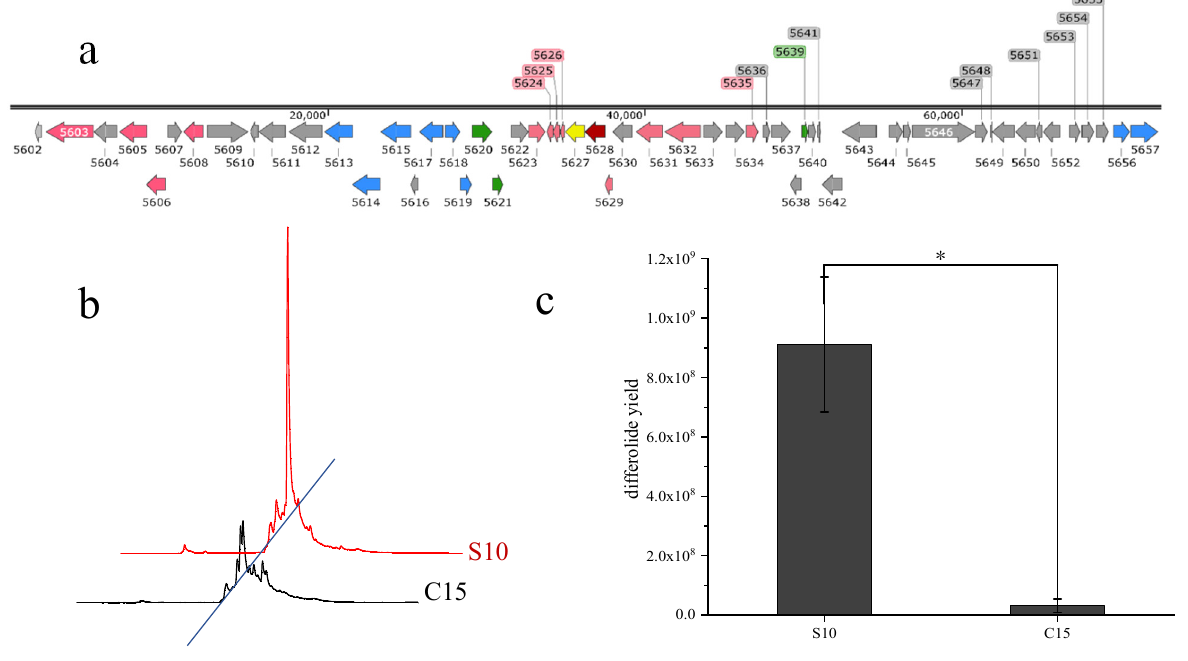
Figure 2. Biosynthesis of (±)-differolide. ( a ): The biosynthesis gene cluster of (±)-differolide (The function of genes was distinguished with a different color. Red: core biosynthetic genes; pink: addi- tional biosynthetic genes; blue: transport-related genes; green: regulatory genes; grey: other genes; yellow: gene 5627, which was knocked out). ( b ): The TIC spectrum of HR-LC-HS between ΔC15 and WT. ( c ): The yield of (±)-differolide difference between ΔC15 and WT (*: The result of significant test showed the R 2 < 0.05). To explore whether the yield of (±)-differolide in the ΔC15 mutant strain is different from that of WT, both were fermented and extracted as above (in triplicate). The produc- tion of (±)-differolide was detected using HR-LC-MS, and the total ion chromatogram (TIC) spectrum of two samples is shown in Figure 2b. The diagonal line in the figure is the peak of the target compound. The results showed that the ion signal of (±)-differolide is much lower in the ΔC15 mutant strain, than that in WT. Comparison of (±)-differolide production in ΔC15 mutant and WT, suggested the yield of the compound in ΔC15 mutant was significantly lower than WT (Figure 2c), indicating that our conclusion is valid, and the C15 BGC is responsible for the biosynthesis of (±)-differolide. 4. Discussion In this study, we isolated a polyketide compound, (±)-differolide, from the desert- inhibiting Streptomyces qaidamensis . Although, (±)-differolide has been known for decades, its bioactivity has not been demonstrated before. In this study, we show its radical scav- enging activity against DPPH for the first time. Researchers have been convinced for a long time that extreme Streptomyces -derived NPs with their structure–activity relationship (SAR) may be a highly promising source for future development of drugs against bacterial infections, especially against multidrug-resistant bacteria [6]. Many polyketides have been confirmed to have antioxidant activity. For example, rhizophols A [21], ascomindones A [22], and hexaricin F/G [23] exhibited DPPH radical scavenging activity. This indicates that (±)-differolide is precisely the antioxidant that may enable S. qaidamensis to survive in the niche. Considering the adaptation strategy of Streptomyces to different extreme